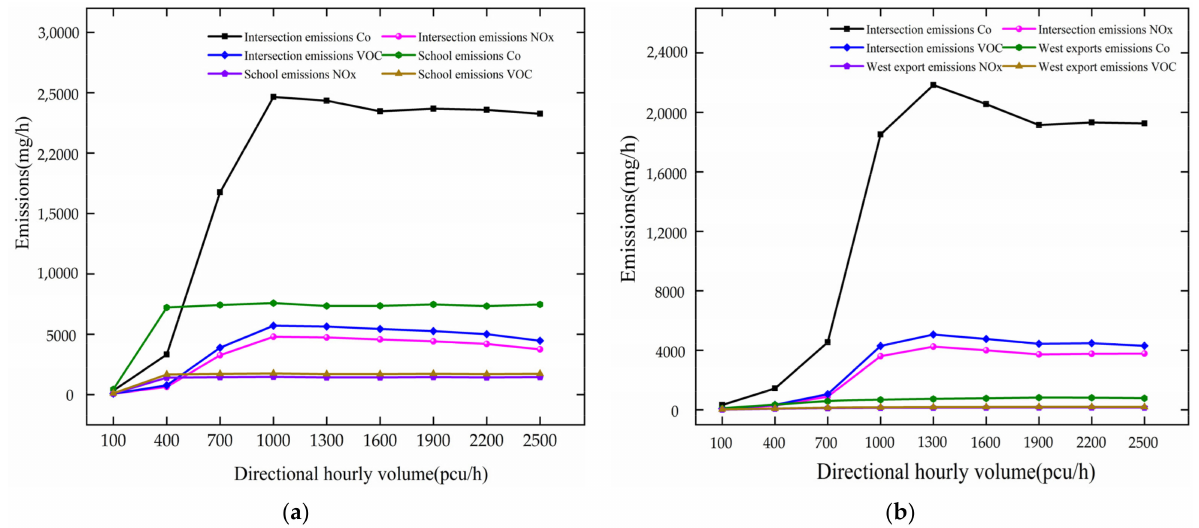
Figure 11. Variation trend of pollutant gas emission with DHV. ( a ) variation trend of pollutants with a school. ( b ) variation trend without a school.